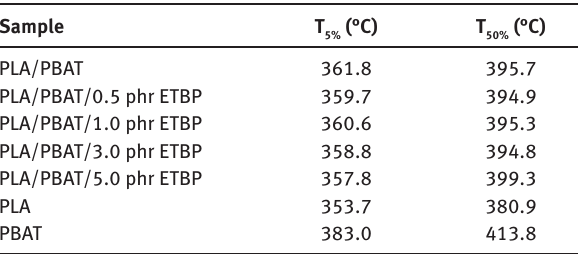
Table 3: Decomposition temperature of the PLA/PBAT blends with different content of ETBP.